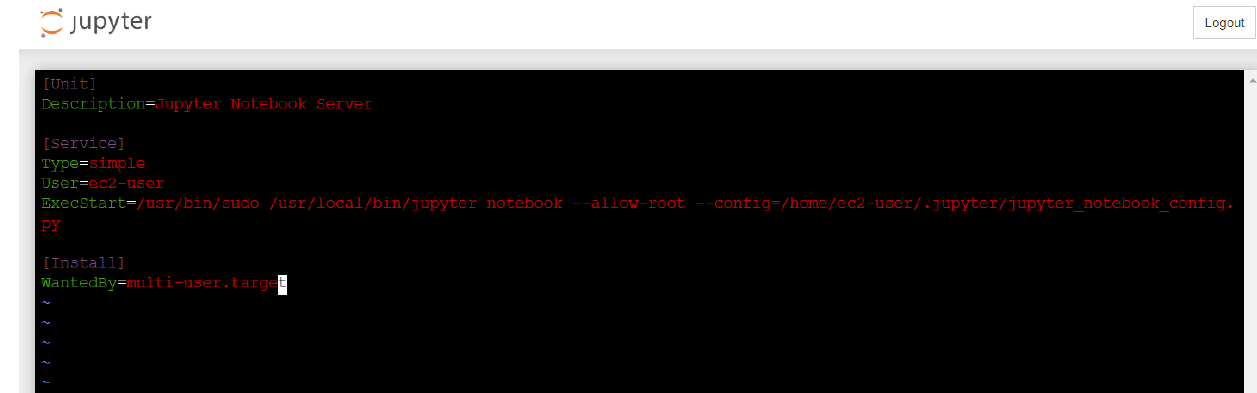
Figure 5. Docker Container-based machine-learning pass/fail inspection system on AWS cloud server environment and a docker-based monitoring system, and image registry interconnection. Jupyter Notebook: as shown in Figure 6, the convenience of the CLI is enhanced by registering the Jupyter Notebook with Jupyter.service for running automatically when Amazon EC2 boots.